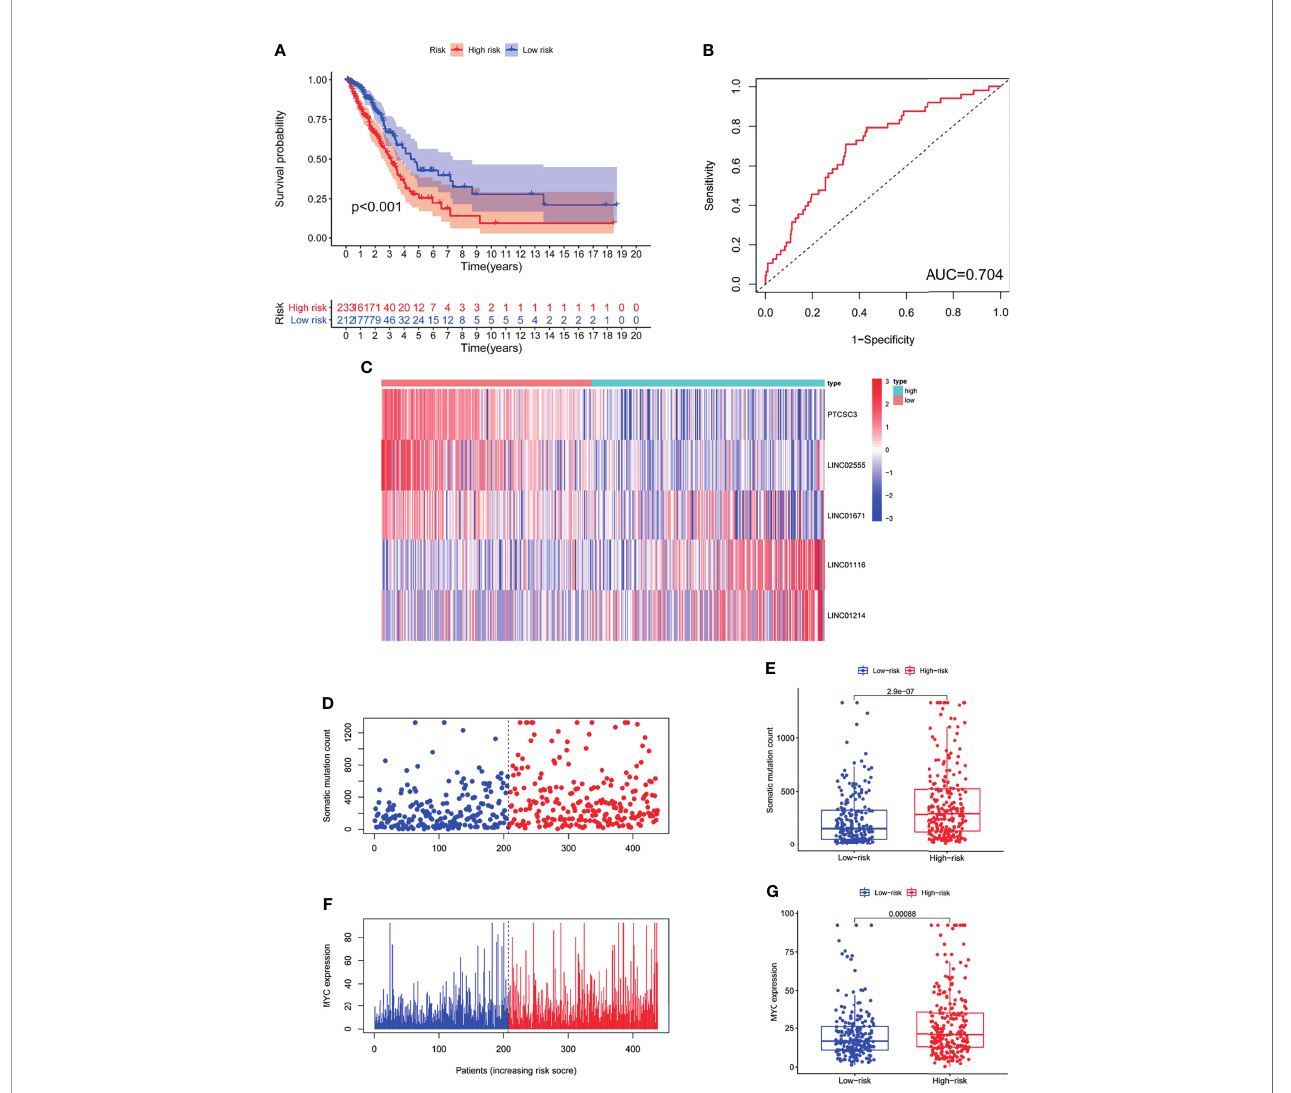
FIGURE 4 | The GILncSig associated with OS of LUAD and property assessment of the GILncSig in the TCGA set. (A) Log-rank test was performed to draw a Kaplan Meier survival curve to predict the overall survival of GILncSig in low- or high-risk patients in the TCGA set. (B) ROC analysis of GILncSig in the TCGA set. (C) Heat map of 5 genomic instability-derived lncRNA expression patterns in TCGA set. (D) The somatic mutation count distribution in the TCGA set. (E) Comparison analysis of somatic mutation count for patients in low- and high-risk groups in the TCGA set. (F) The distribution of MYC expression in the TCGA set. (G) Comparison analysis of MYC expression in low- and high-risk groups in the TCGA